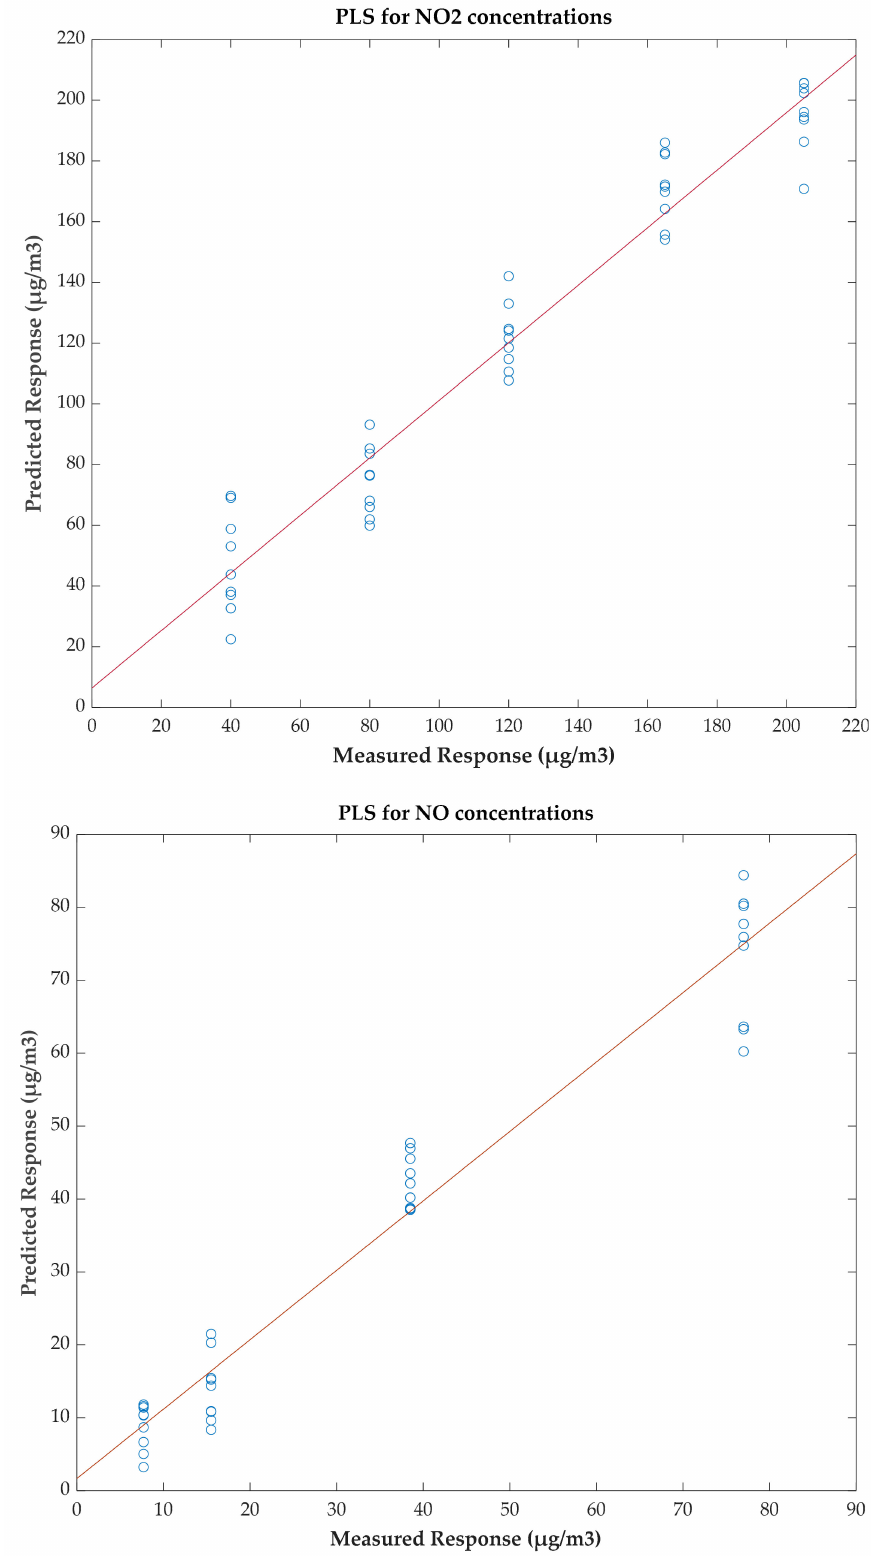
Figure 7. Partial Least Squares (PLS)